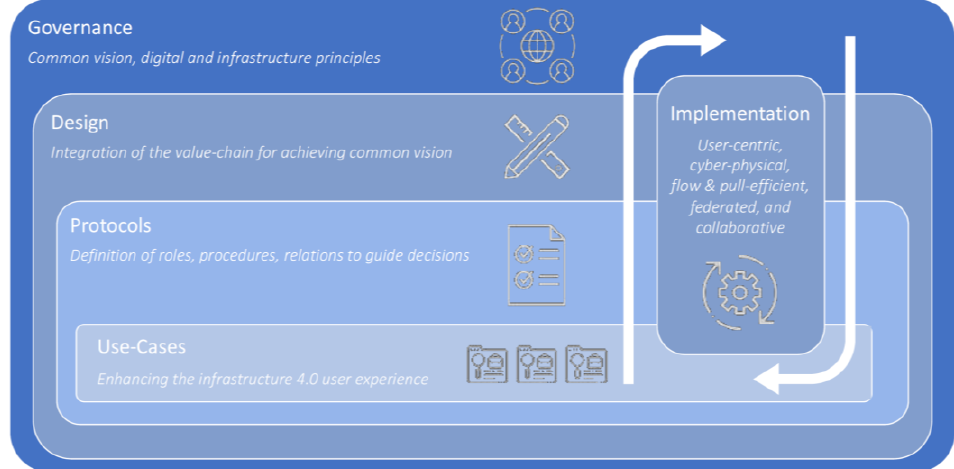
Figure 6. Five dimensions of implementing a mobilization and learning platform (authors’ own re- search and depiction